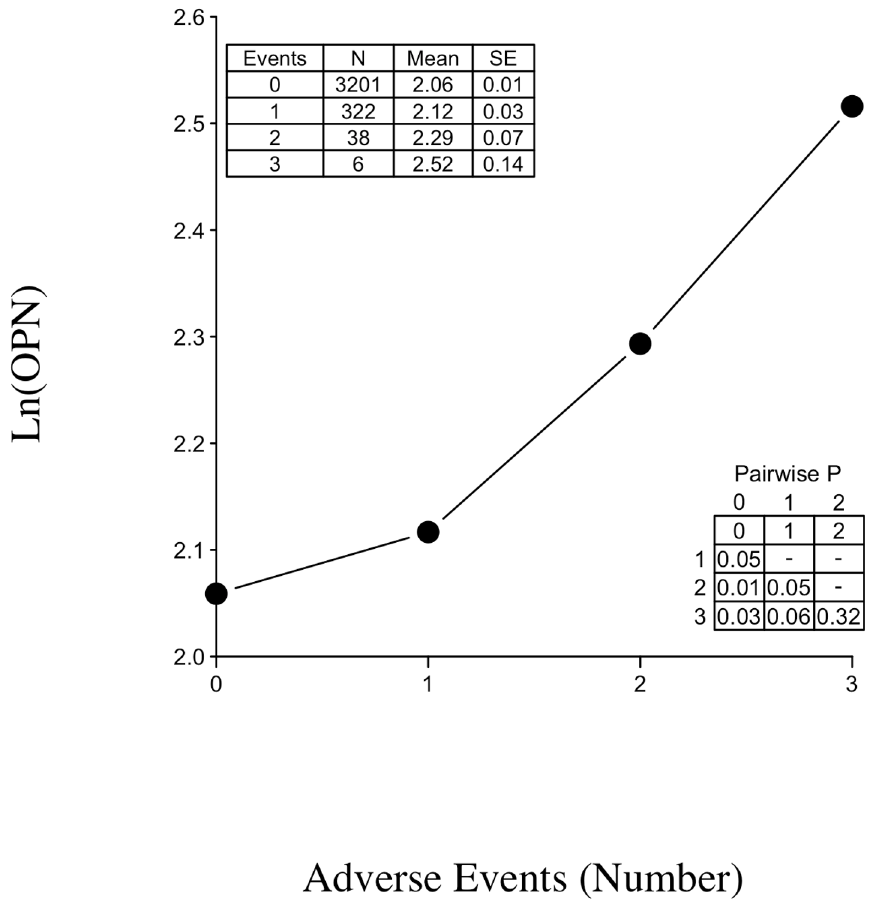
Fig 2. Scatterplot of mean Ln OPN level of samples grouped by number of adverse events incurred. Inset tables contain summary statistics and P -values for pairwise comparisons of the